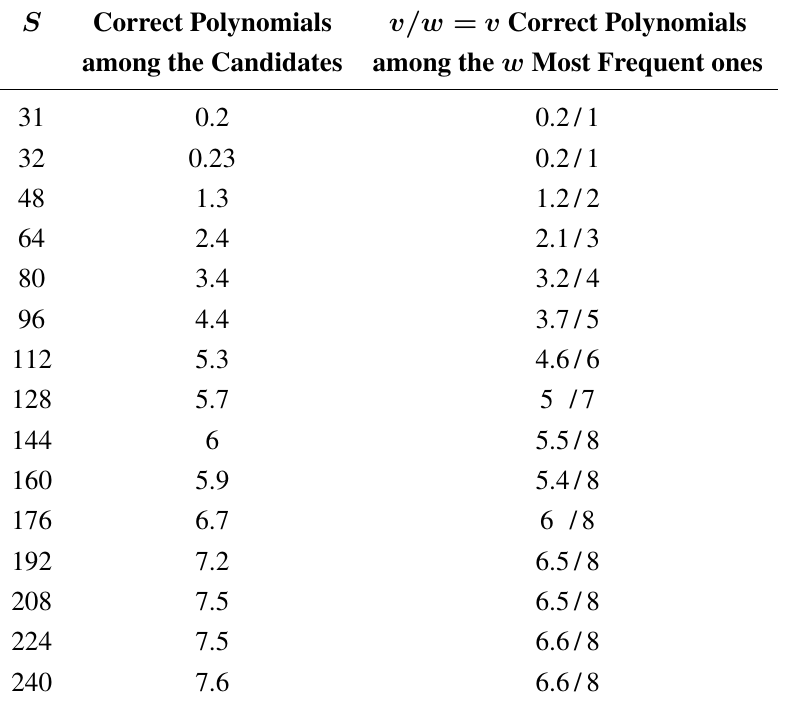
Table 2. Average retrieved